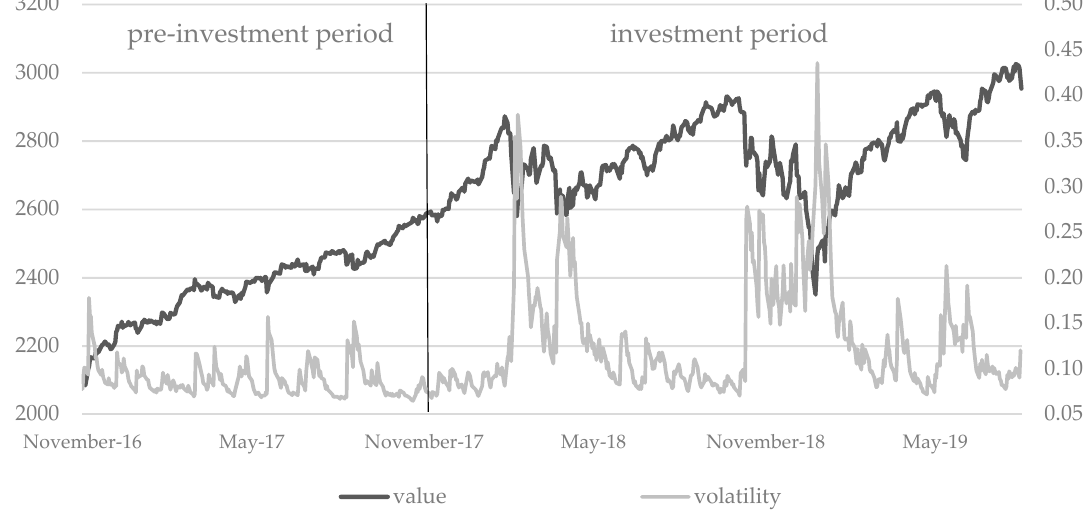
Figure 3. The S&P 500 index - value and the volatility (November 2016–June 2019). Volatility is obtained from the GARCH(1,1) model.